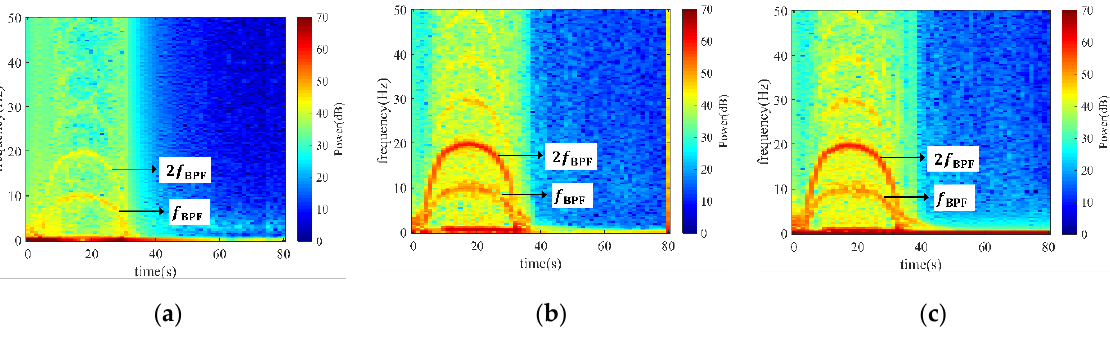
Figure 10. STFT of runner moment in three orthogonal directions x , y , and z . ( a ) Axial moment in the x direction; ( b ) diagonal-radial moment in the y direction; ( c ) horizontal-radial moment in the z direction.